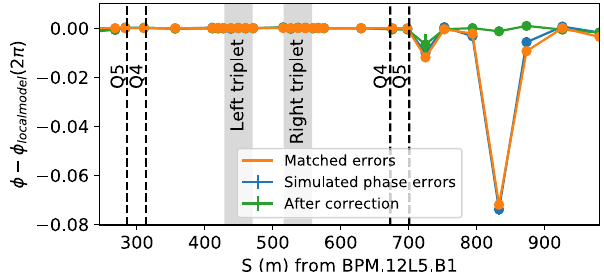
FIG. 1. Example of a simulation of the HL-LHC with quad- rupolar errors in the triplet and Q4-5. The blue line shows the deviation of the phase-advance from the design model of the segment. The orange line is the suggested effective correction and the green the effect of the correction.